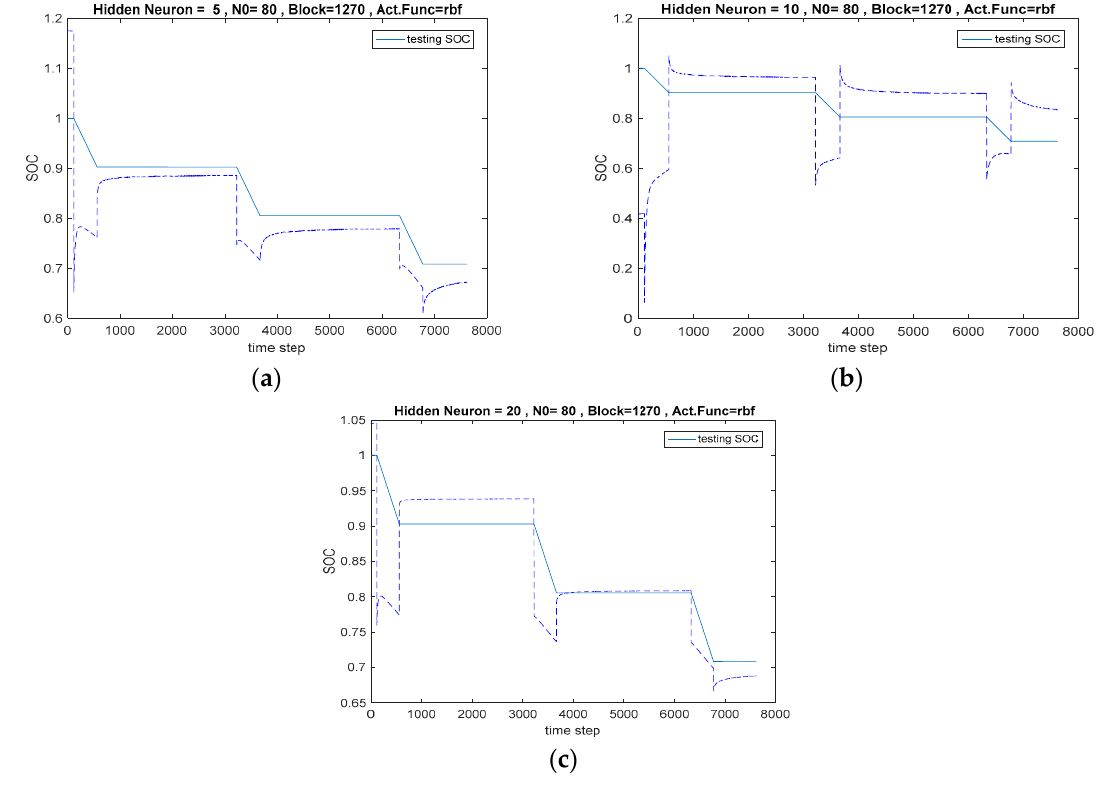
Figure 15. SOC testing performance of online sequential ELM at 25 °C ambient temperature (for different neuron numbers). ( a ) 5 neurons, ( b ) 10 neurons, ( c ) 20 neurons.